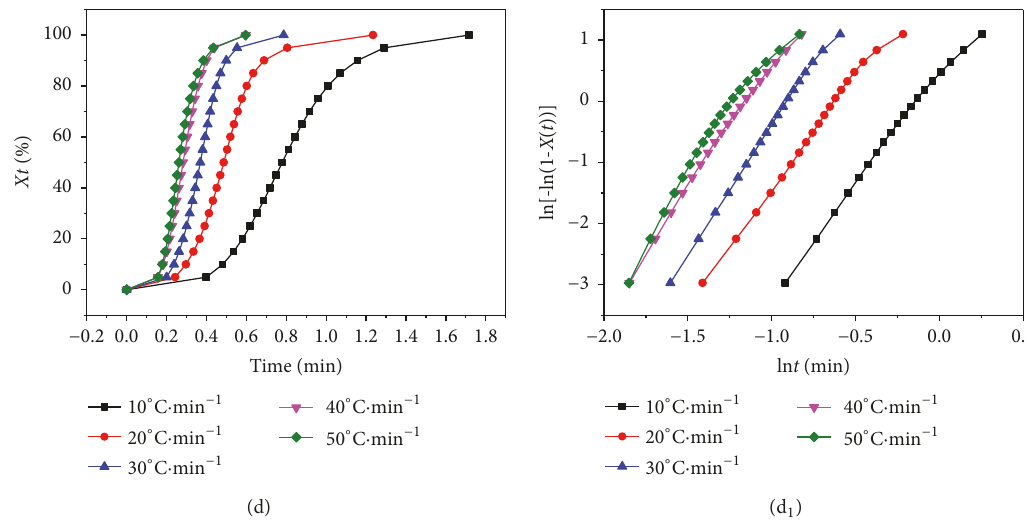
Figure 7: Relationship between X ( t ) and t , ln [ -ln (1 - 𝑋(𝑡))] , and ln 𝑡 at different cooling rates for rPP and its composites: (a-a 1 ) pure rPP, (b-b 1 ) MCC/rPP (60/40), (c-c 1 ) MCC/PP-g-MA/rPP (60/5/35), (d-d 1 ) T-ZnOw/MCC/PP-g-MA/rPP